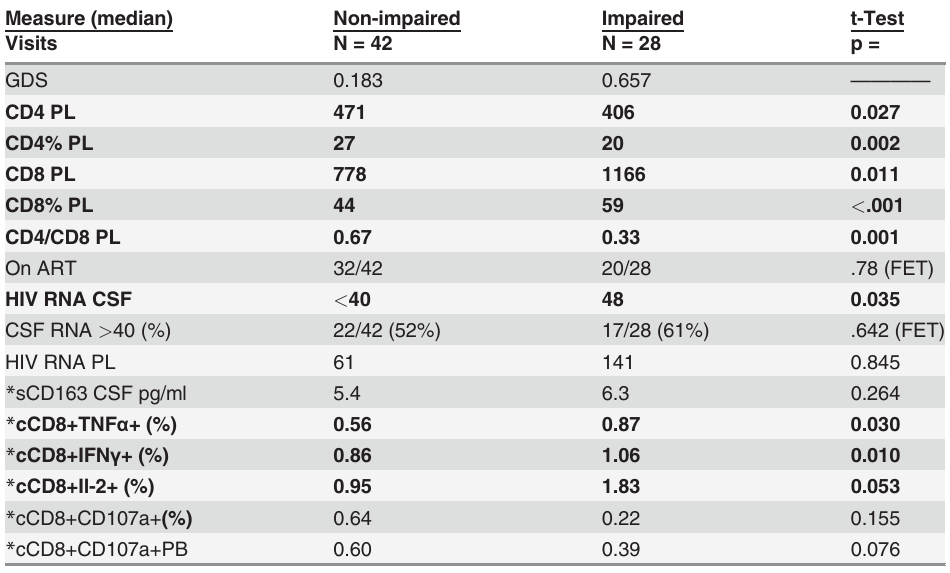
Table 3. Neurocognitive impairment is associated with a low CD4/CD8 ratio in plasma and higher CD8+T-cell cytokine expression in CSF.